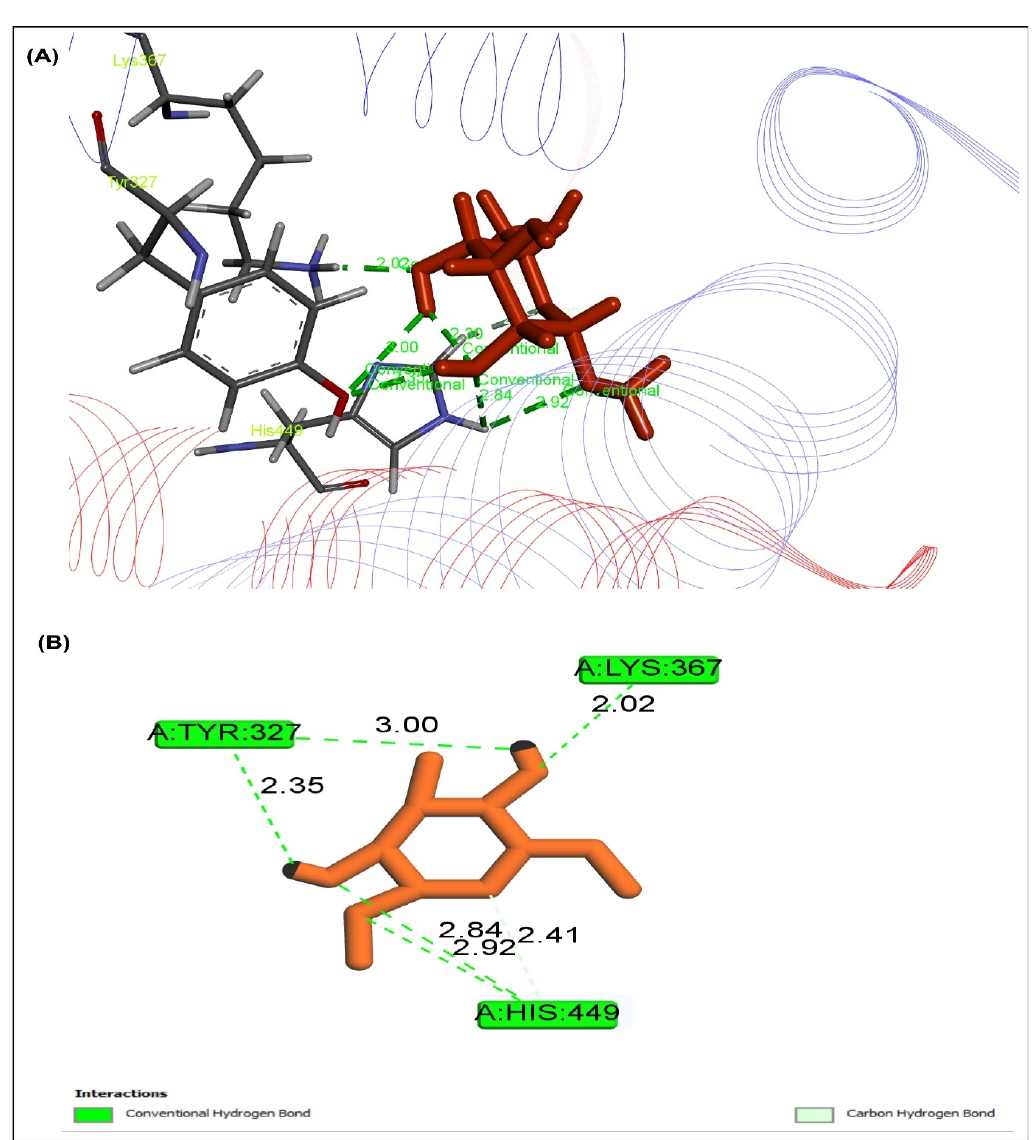
Figure 7. Docking study showed that the highest rank poses of methyl α - D -galactopyranoside docked with the active site PPAR γ for antidiabetic potential in ( A ) 2D and ( B ) 3D molecular interactions.